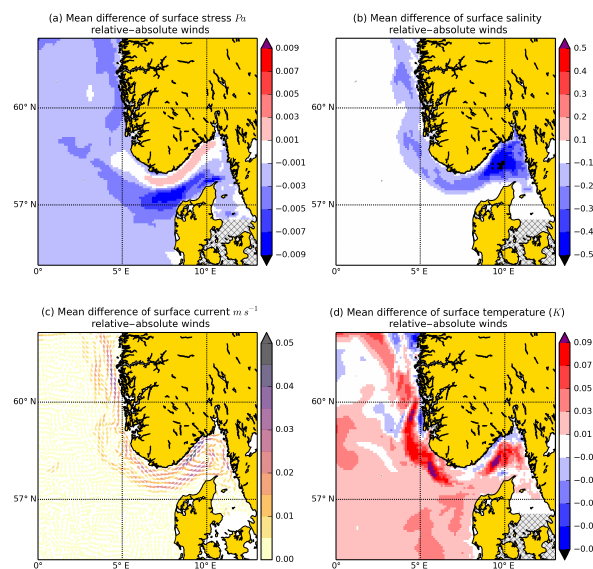
Figure 19. Comparison between using wind velocity relative to ocean surface and absolute wind velocity for the 2011 annual mean. Panel (a) shows the difference in surface shear stress in Pa. Panel (b) shows the difference in surface salinity. Panel (c) shows the dif- ference in surface current. Panel (d) shows the difference in surface